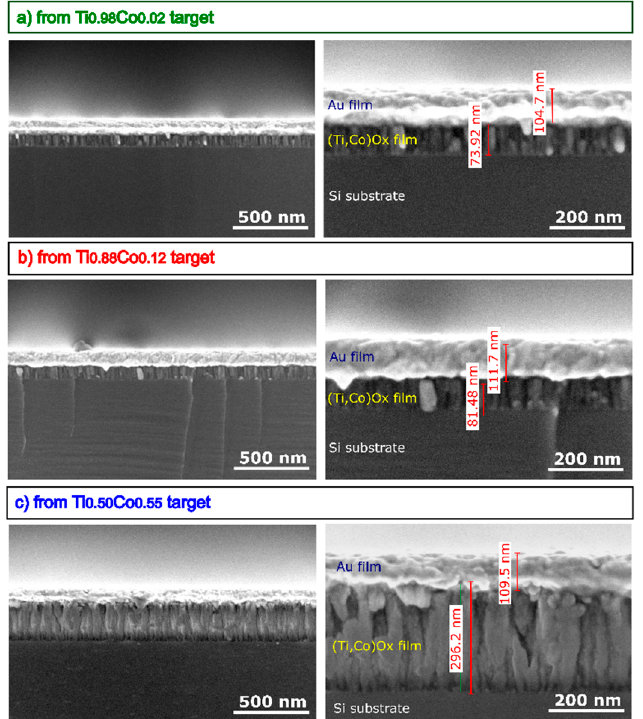
Figure 9. SEM images of cross-section of (Ti,Co)Ox thin films prepared from: ( a ) Ti 0.98 Co 0.02 , ( b ) Ti 0.88 Co 0.12 , ( c ) Ti 0.50 Co 0.50 targets (with Au layer on top).